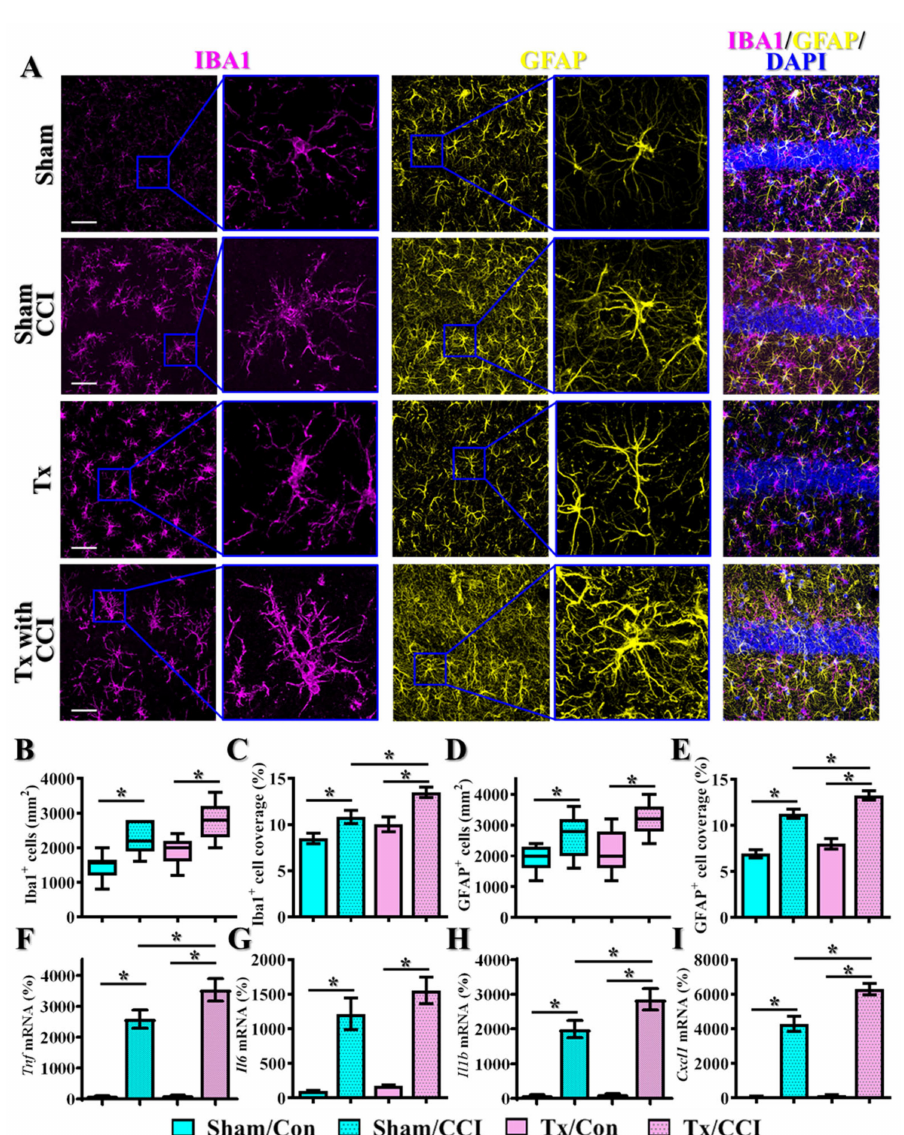
Figure 6. Increase in microgliosis and astrogliosis after CCI in the thyroidectomized animals. ( A ) Representative images of IBA1-positive microglial cells (color in magenta) and GFAP-positive astroglial cells (color in yellow) from different experimental groups. Blue, DAPI signal for the nuclear stain. Scale = 25 µ m; ( B , C ) Quantification of the regional density and percentage of area covered by IBA1-positive cells; ( D , E ) Quantification of the regional density and percentage of area covered by GFAP-positive cells. n = 15 images from 5 mice in ( B – E ). ( F – I ) Quantification of the relative expression levels of Tnf , Il6, Il1b and Cxcl1 mRNAs from different experimental groups with sham-operated or surgical removal of thyroid glands. n = 5 mice. All the data are presented as mean ± SEM and